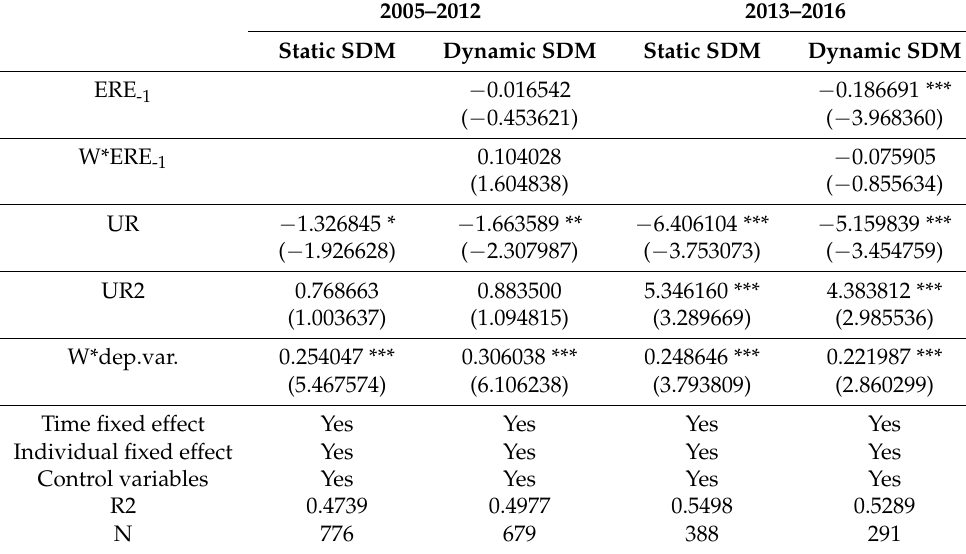
Table 9. Estimation results of SDM during different time